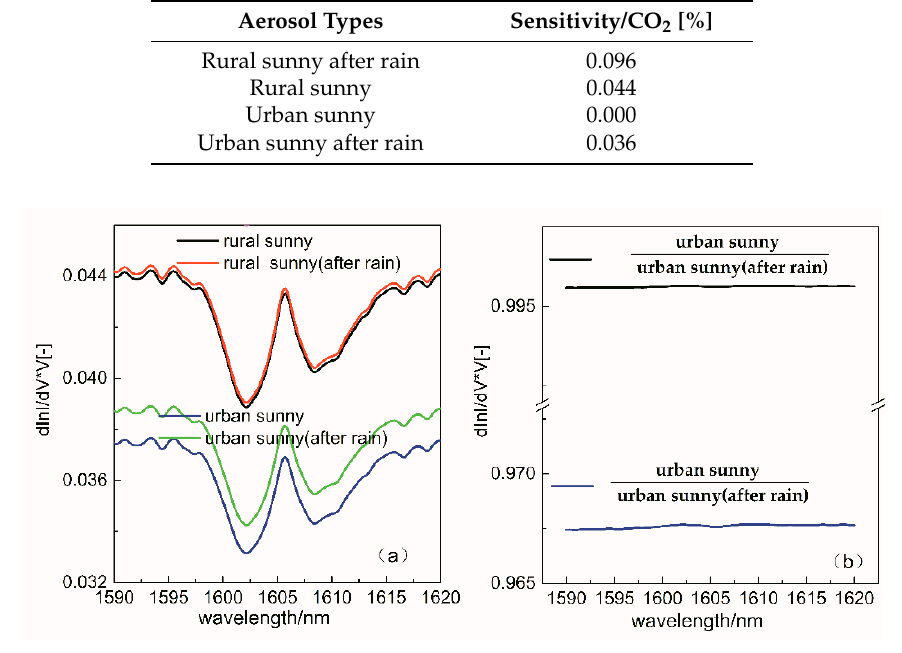
Figure 7. ( a ) CO 2 CWF under four different scenarios (urban and rural areas and continuous sunny days and sunny days after rain) and ( b ) CO 2 CWF ratio between the two types of sunny days for the same aerosol scenario.